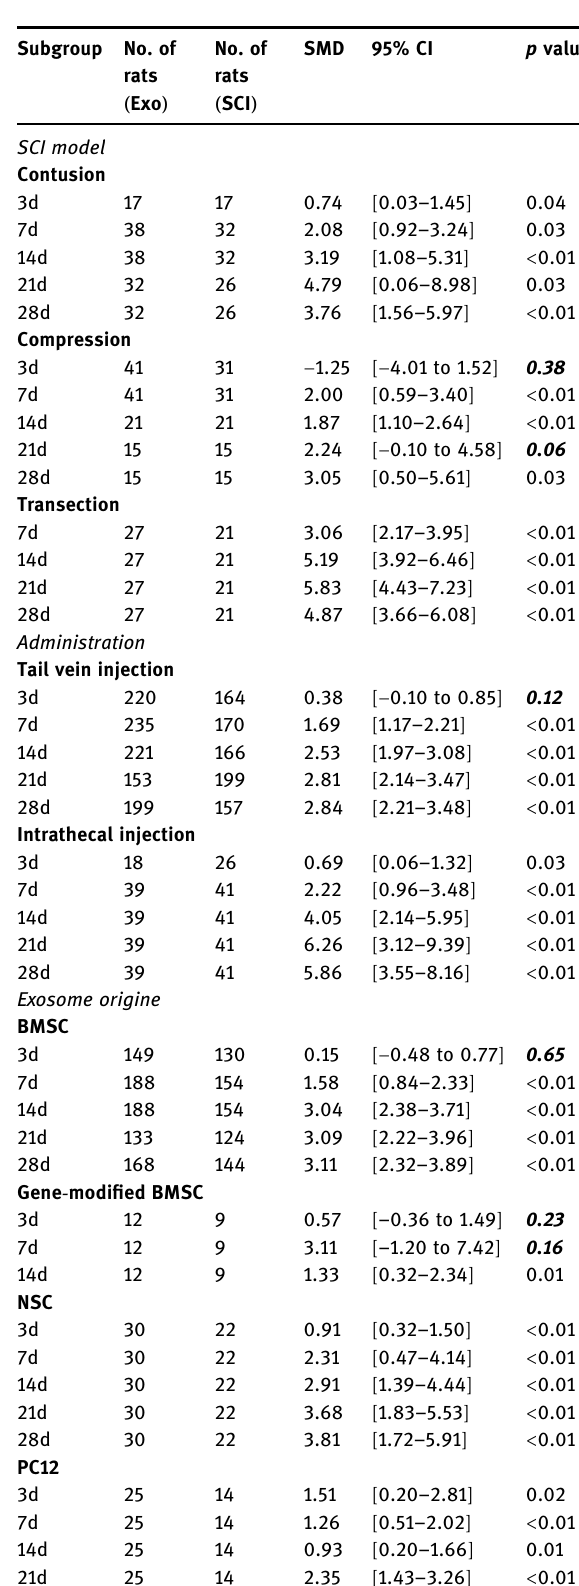
Table 2: Subgroup analysis of rat models, administration modes and exosome